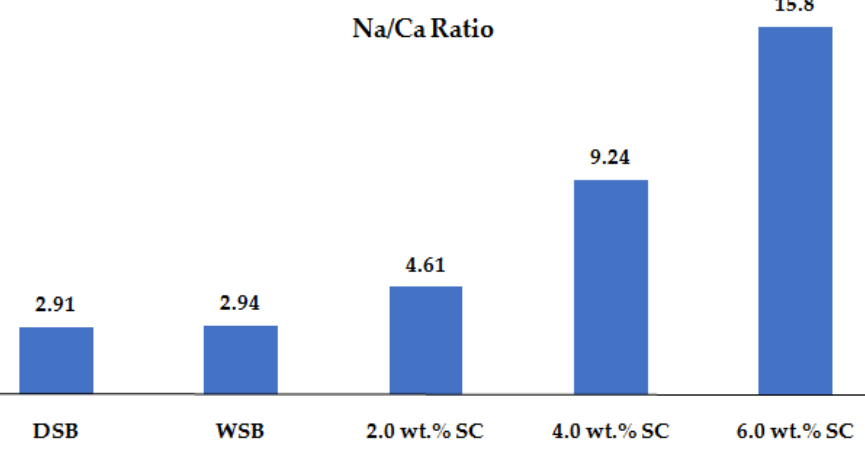
Figure 7. Na/Ca ratios for the neat clays (dried and wet sieved samples) and Na 2 CO 3 -activated ones. Note: WSB — wet sieved bentonite; SC — sodium carbonate. Table 4. Sodium and calcium contents measured by EDX analysis for raw, purified, and activated bentonite